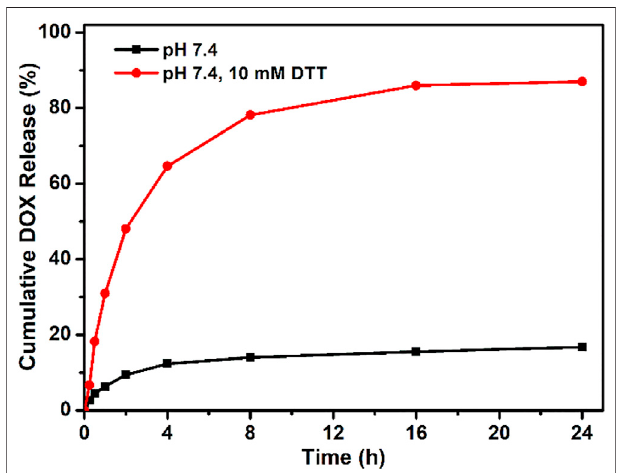
FIGURE 4 | Reducing agent of DTT-triggered DOX release from PEG – disul fi de – DOX micelles with or without DTT (10 mM) solutions at 37 ° C. The drug release pro fi le re fl ects the reduction response of the micelles with good stability in neutral environment and quick dissociation in reductive